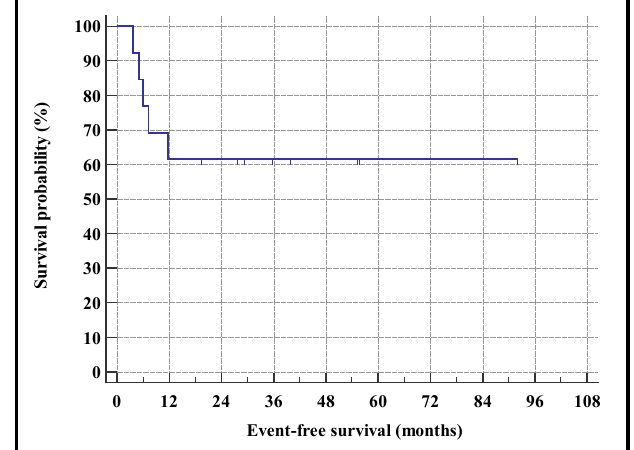
Figure 5: Kaplan-Meier curve of event-free survival of 13 children with vaginal germ cell